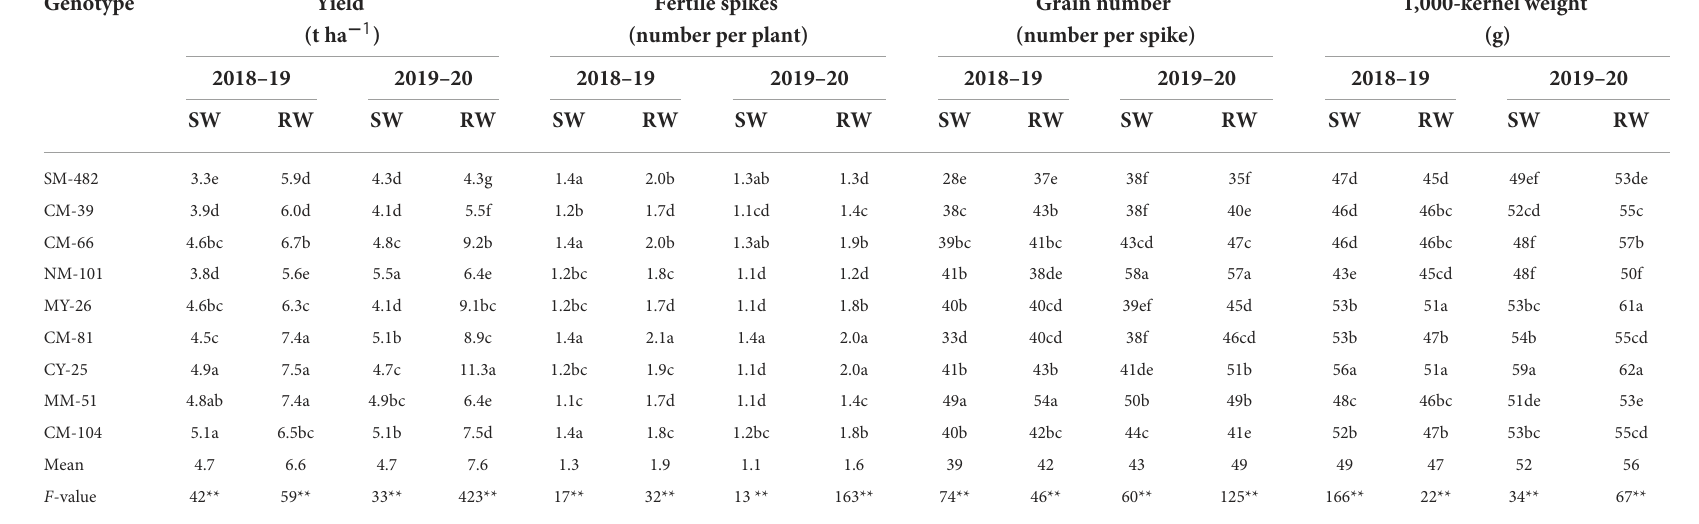
TABLE 3 The grain yield and yield components of nine wheat genotypes in two wheat cropping systems and two cropping years. Genotype Yield